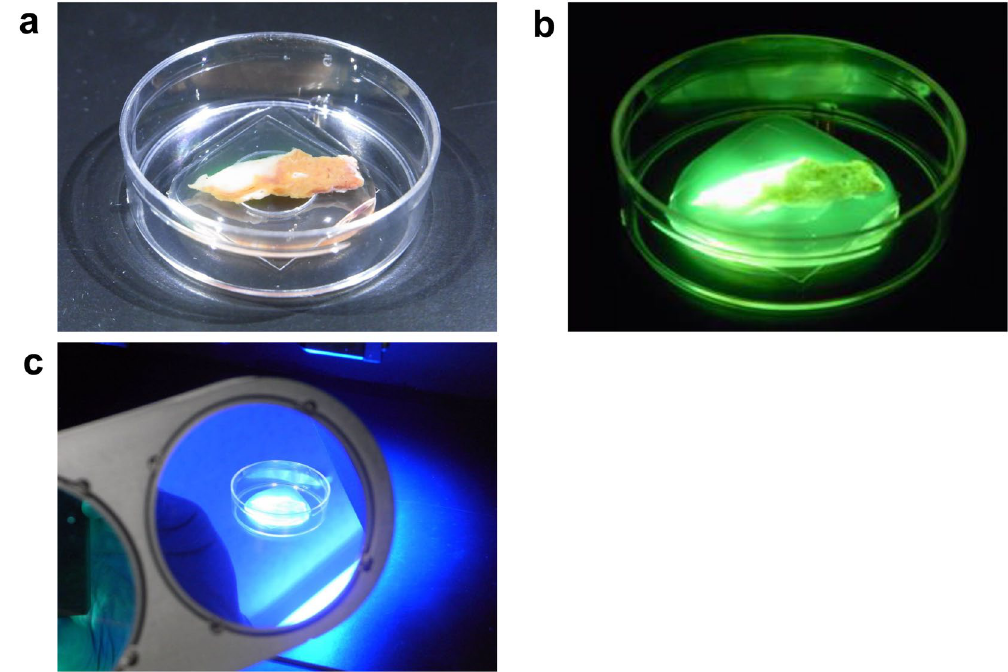
Figure 2. Naked-eye observation of fluorescence signals following topical administration of gGlu-HMRG on resected hepatic tissues. ( a ) gGlu-HMRG was sprayed on to cut surface of a resected hepatic specimen including ICC. ( b ) Cancerous tissues of ICC were identified as a highly fluorescing legion by naked-eye examination. ( c ) Fluorescence signals were observed through a filter glass (515 nm, long pass) under blue-light illumination (445–490